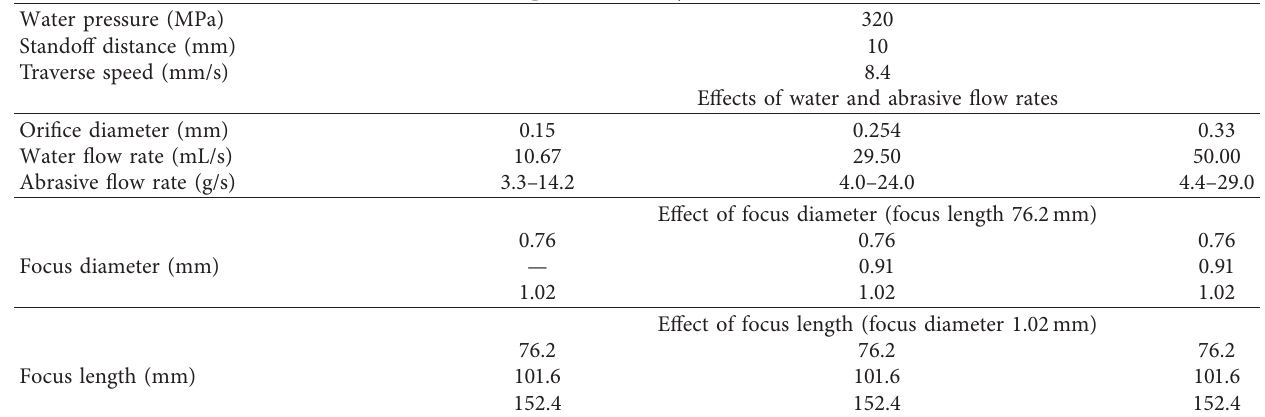
Figure 4: Various types of orifices and focuses. Table 1: Experimental study cases and